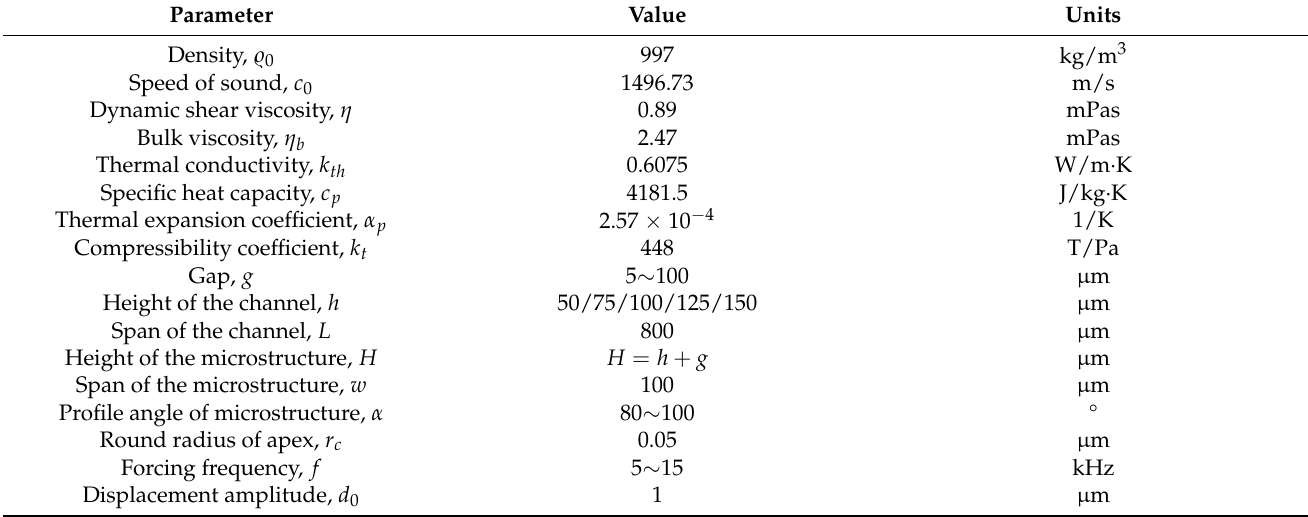
Figure 2. Two − dimensional simulation model is established to analyze the effect of side profile on streaming. ( a ) The model’s geometry and representative parameters as well as the movement and temperature boundary conditions are presented, where the black dotted line is the fluid-solid coupling boundary applied V 1 = V a e − i ω t . ( b ) The wavelength λ of sound wave propagation in fluid. ( c ) The model is axisymmetric, the left side represents the physical domain including fluids and solids, and the right side represents the mesh situation with ( d ) a magnified view around the tip. Table 1. Constitutive and operational